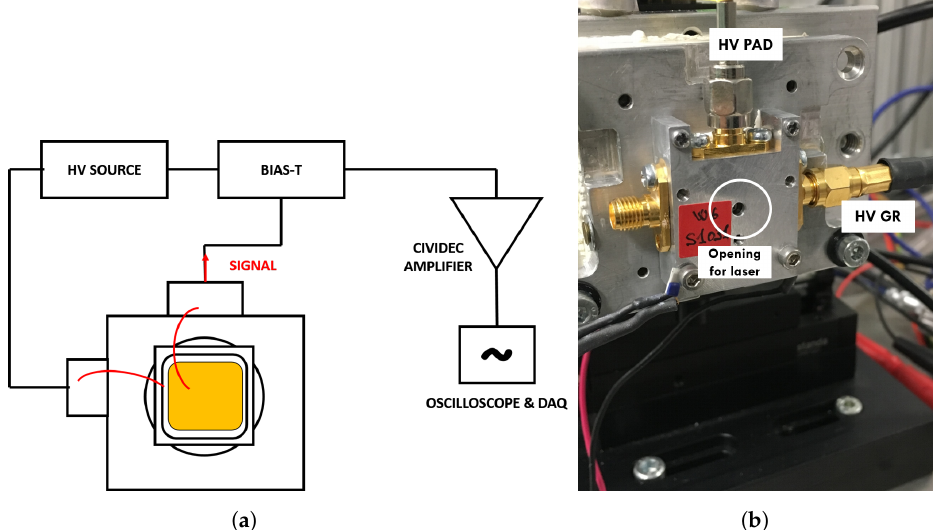
Figure 6. ( a ) Sketch of the setup used for the TCT measurements. ( b ) Metal box in which the sensor is located, mounted on the X-Y movable stage.